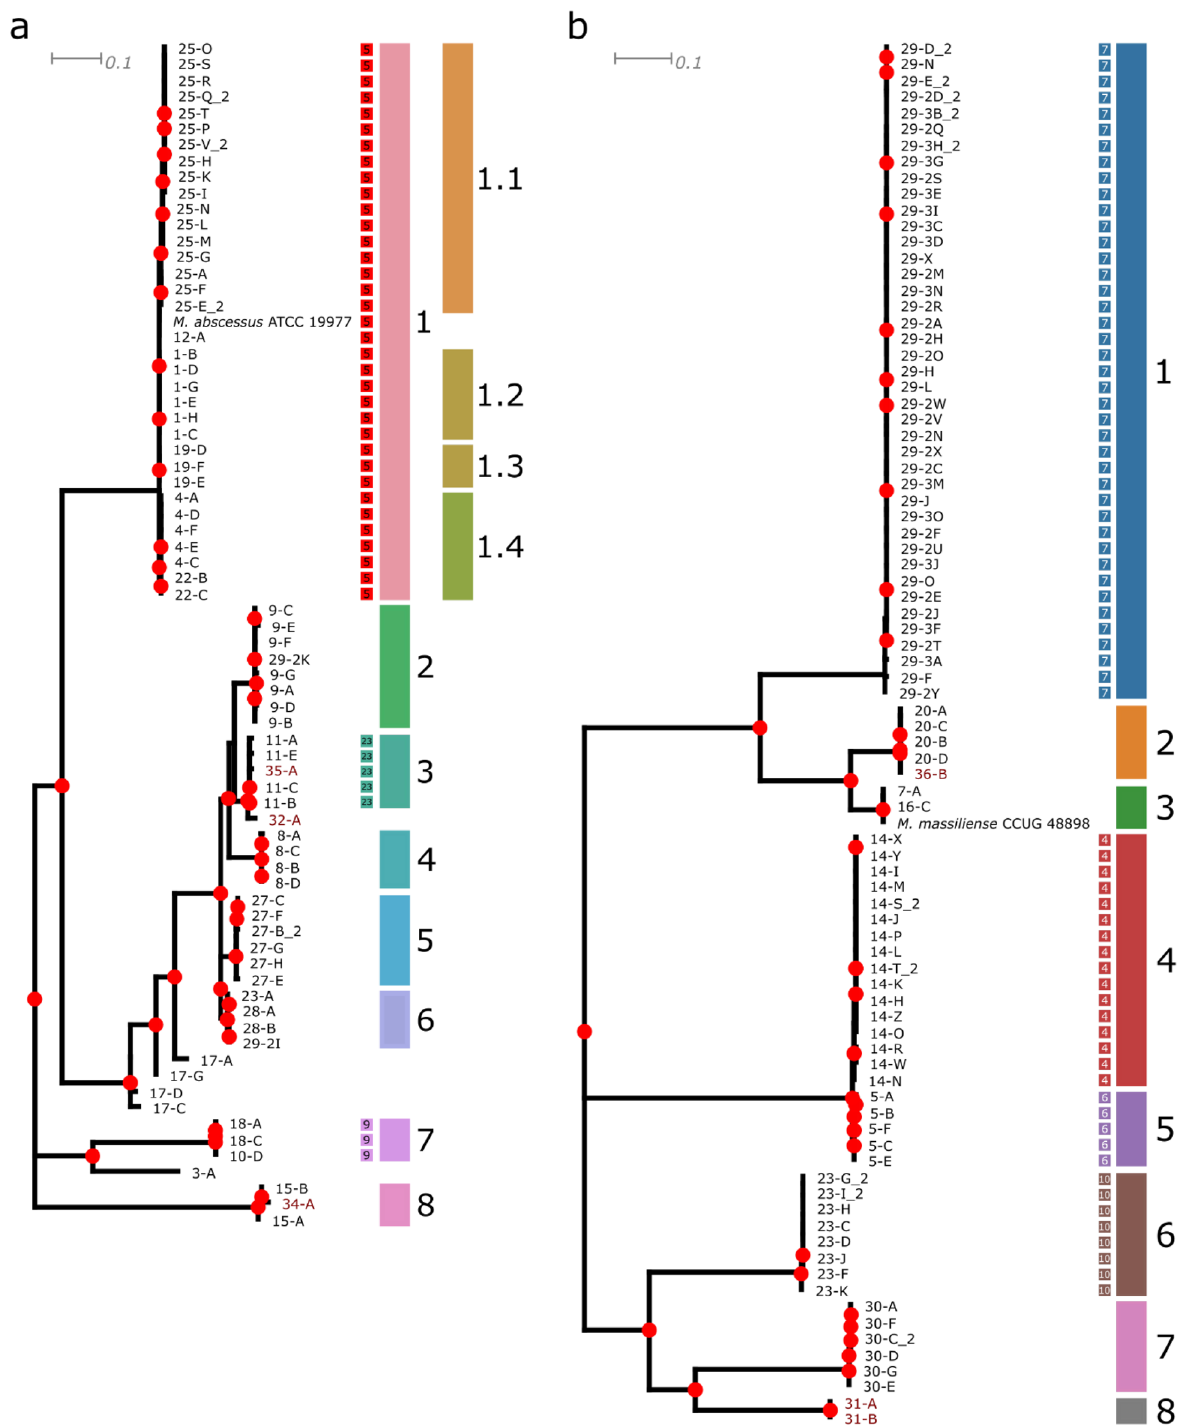
Figure 2. Subspecies maximum likelihood phylogeny. These phylogenies were constructed from the recombination-masked SNV alignment, and drawn using the midpoint root. Bootstrap support > 80% is indicated on nodes with red circles. The seven locus ( argH , cya , gnd , murC , pta , purH , and rpoB ) PubMLST sequence types (ST) are indicated in coloured squares where an existing ST could be assigned (see Methods). Isolates from patients with CF are indicated in black, while those from non-CF patients are indicated in dark red. a M. abscessus. b M. massiliense